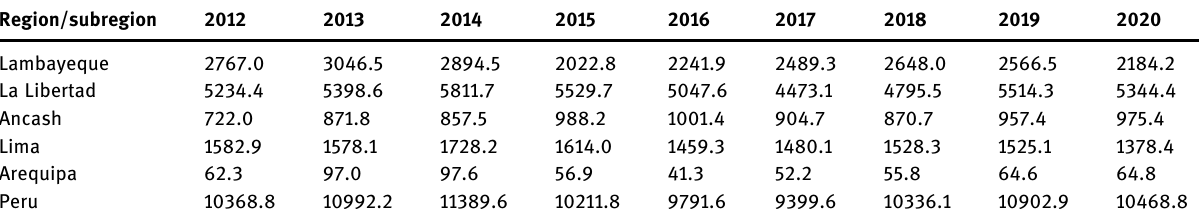
Region/subregion